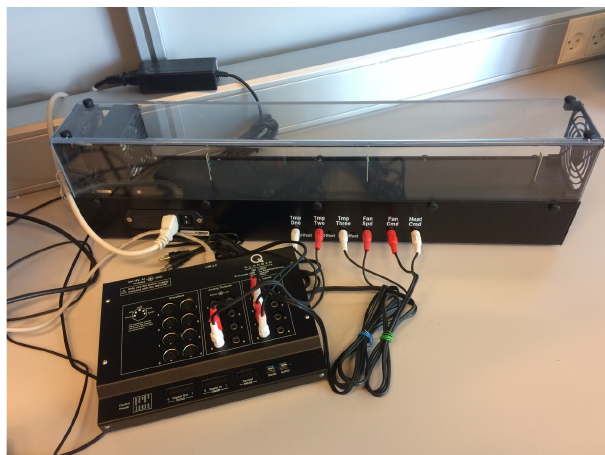
Figure 5: Quanser Heat Flow Experimental